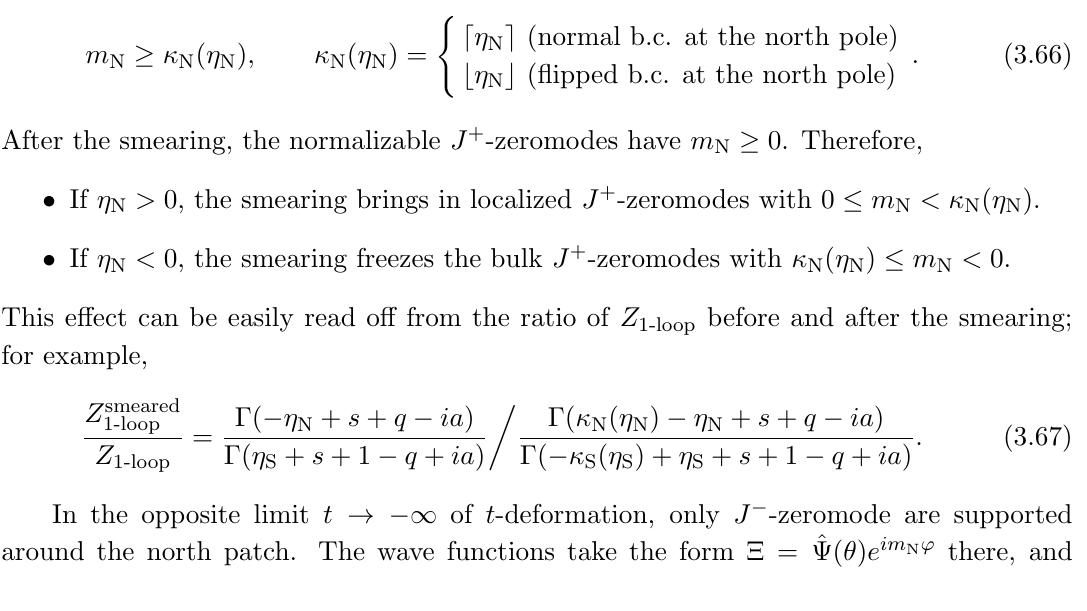
(cid:20) (cid:18) 1 1 + exp u